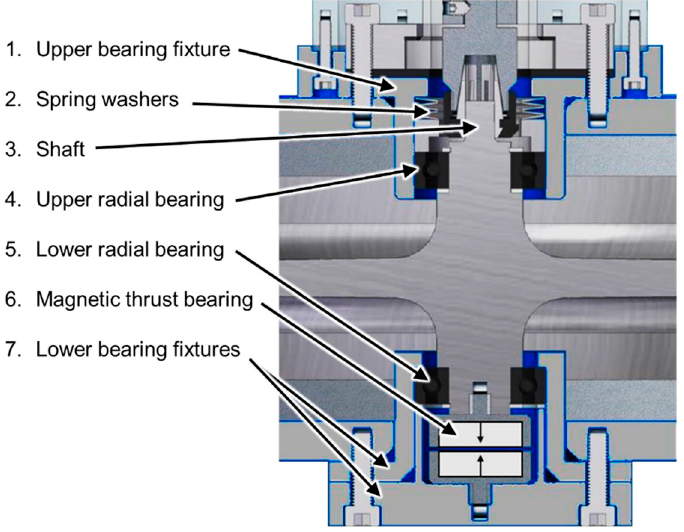
Figure 2 : Schematic with labeled components of the upper and lower bearing sub ‐ assemblies. Figure 2. Schematic with labeled components of the upper and lower bearing